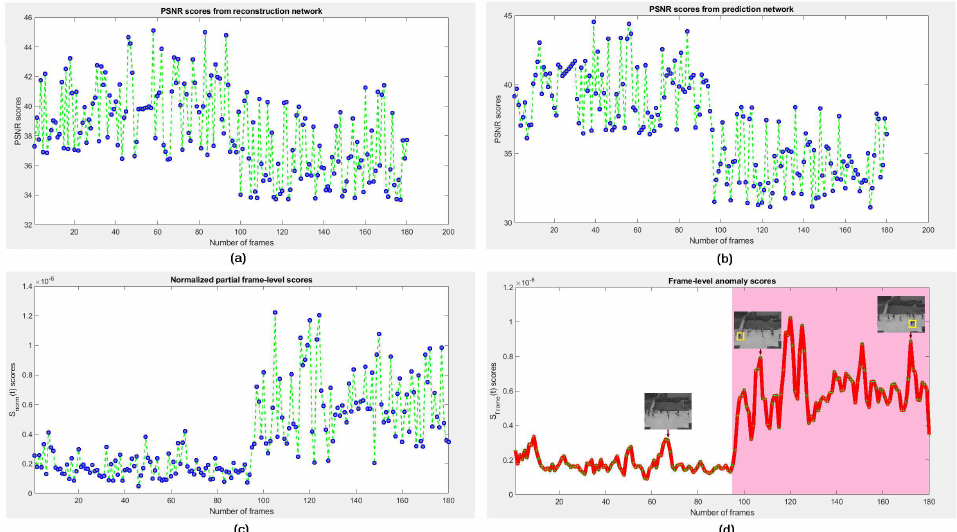
Figure 14. A sample output using UCSD-Ped2 [31], where a bicycle anomaly was happened. ( a , b ) exhibit PSNR scores, whereas ( c , d ) show frame-level